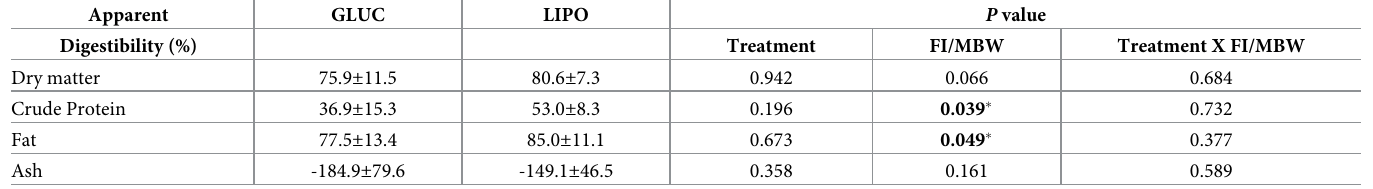
Statistically significant (p <